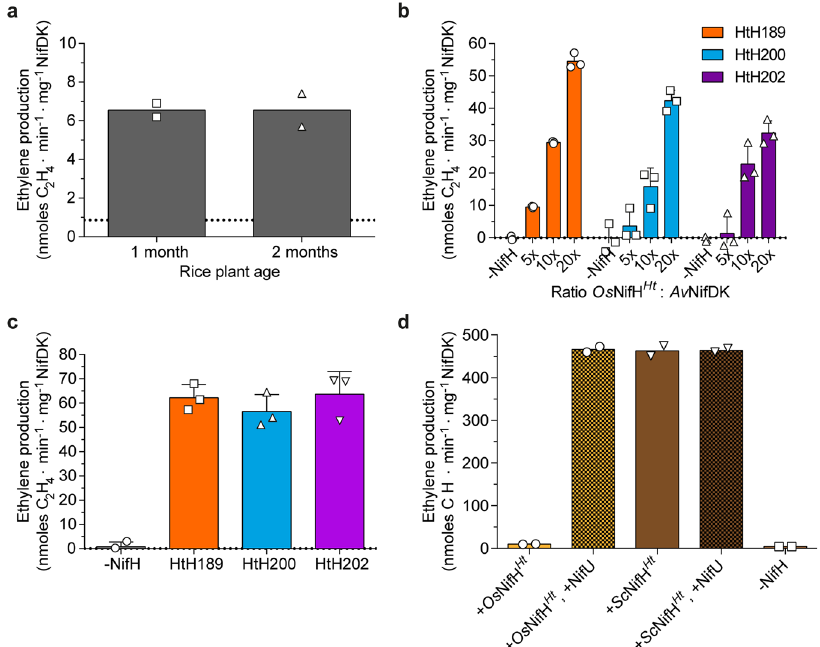
Fig. 3 Acetylene reduction assay (ARA) with puri fi ed Os NifH Ht . a ARA using Os NifH Ht isolated from HtH200 rice plants (10:1 ratio of Os NifH Ht :NifDK Av ) (data are means± SD, n = 2 technical replicates). Dotted line indicates the negative control ARA in the absence of NifH (mean of n = 3 technical replicates). The positive control ARA (40:1 ratio of NifH Av :NifDK Av ) generated 1285 ± 225 units (mean ± SD, n = 3 technical replicates). b ARA with increasing amounts of Os NifH Ht isolated from three different rice callus lines (0, 5:1, 10:1 and 20:1 ratio of Os NifH Ht :NifDK Av ). The positive control ARA (20:1 ratio of NifH Av :NifDK Av ) generated 1426 ± 43 units for Ht189, 1127 ± 65 units for Ht200 and 1074 ± 153 units for Ht202 (data are means ± SD, n = 3 technical replicates). c ARA using Os NifH Ht isolated from three different rice callus lines at a 40:1 ratio of Os NifH Ht :NifDK Av . The positive control ARA (40:1 ratio of NifH Av :NifDK Av ) generated 1285 ± 225 units (data are means ± SD, n = 3 technical replicates). d ARA using Os NifH Ht and Sc NifH Ht before and after reconstitution with [4Fe-4S] cluster-loaded Ec NifU Av . The positive control ARA (using NifH Av ) generated 1553 ± 82 units. All reactions were performed with a 20:1 ratio of NifH:NifDK Av (data are means ± SD, n = 2 technical replicates). All activities are reported as nmol ethylene formed per min and mg of NifDK Av